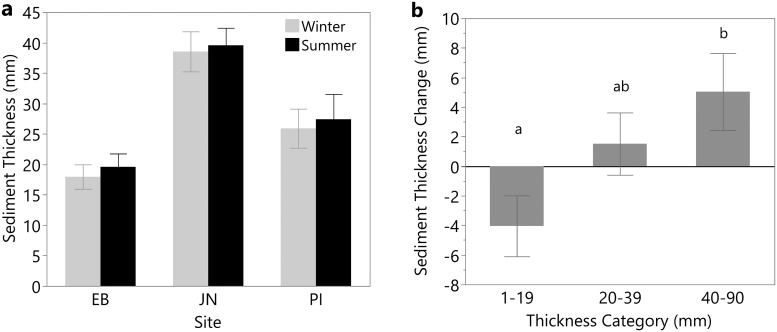
(a) Sediment thickness at each site in winter and summer. (b) The change in thickness of deposited sediment between winter and summer of 2018 for each thickness category. Different letters denote significant differences among thickness categories (Tukey’s HSD). Error bars show standard error.